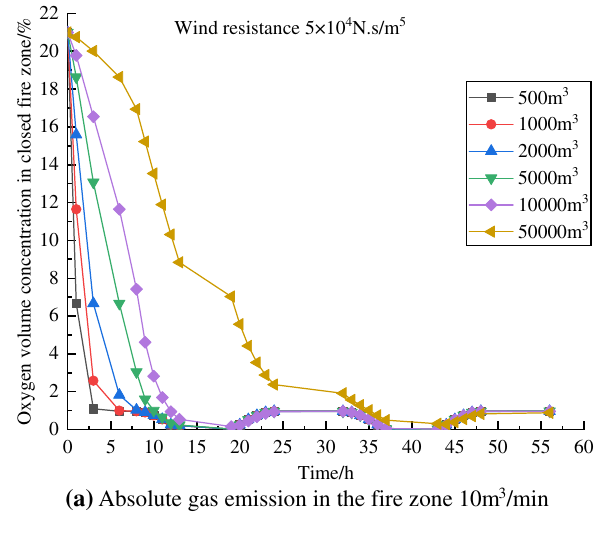
(a) Absolute gas emission in the fire zone 10m 3 /min